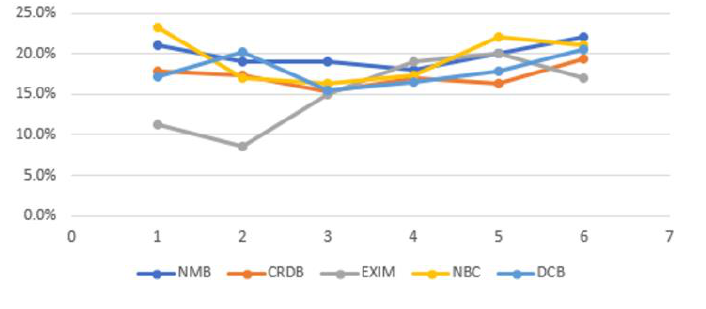
Figure 1: Capital Adequacy